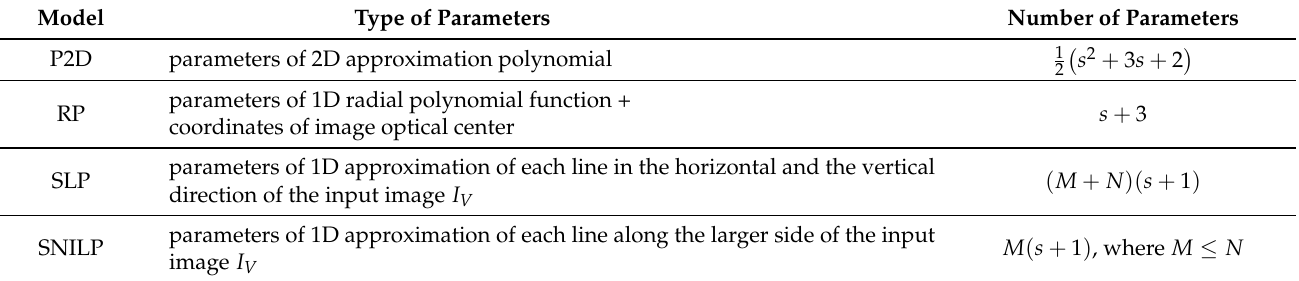
Table 7. The number of parameters required for saving vignetting estimation results.